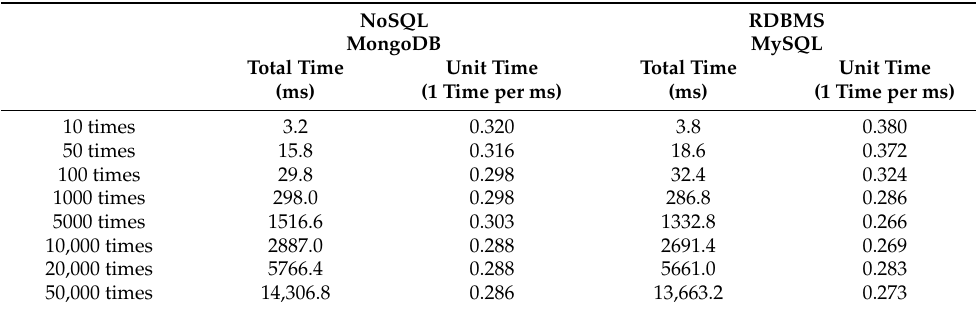
Table 2. Results of read